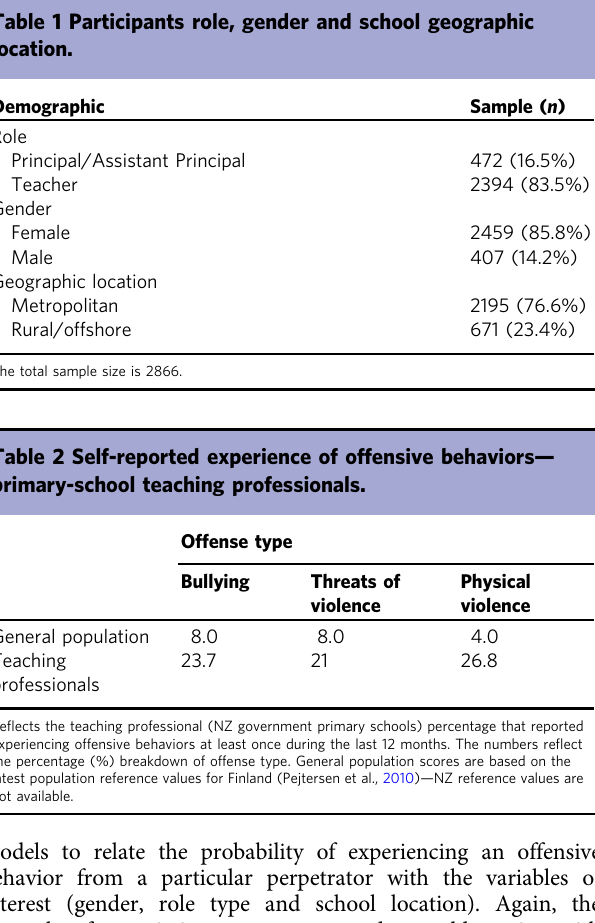
Table 1 Participants role, gender and school geographic